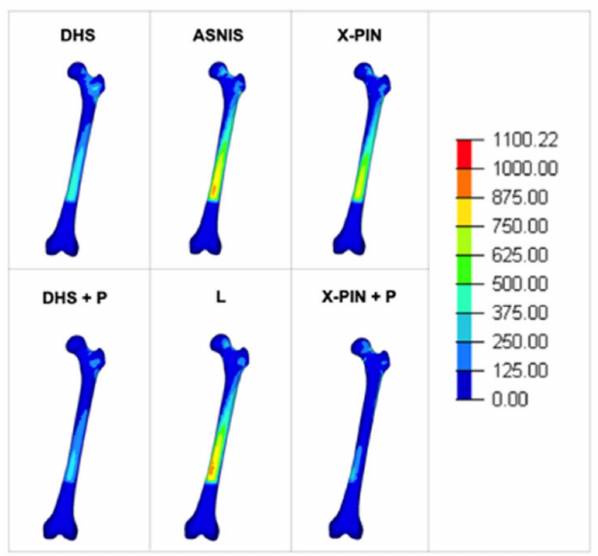
Figure 6. Maximum principal tension in the models.